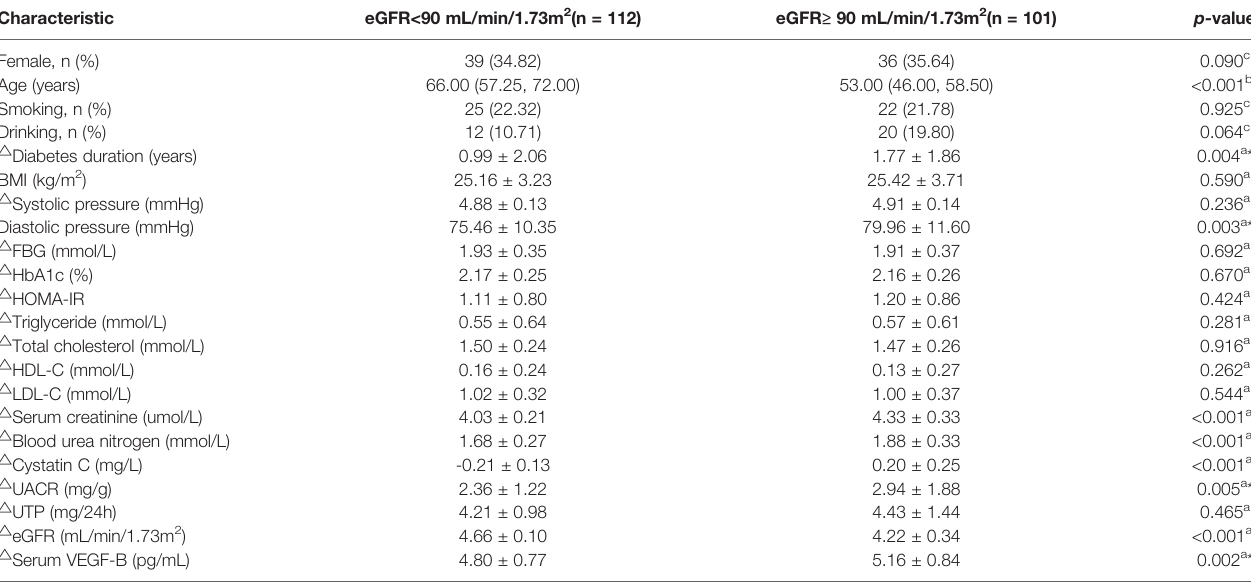
TABLE 1 | Anthropometric characteristics, clinical characteristics and VEGF-B levels.